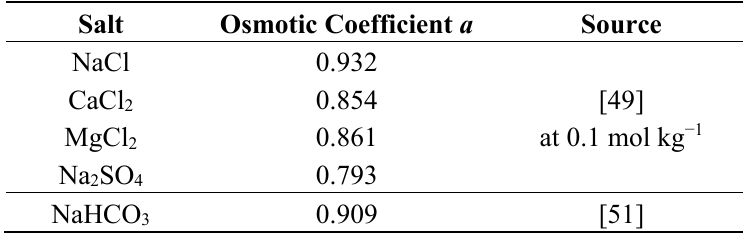
Table A1. Osmotic coefficients for dilute solutions used in Equation